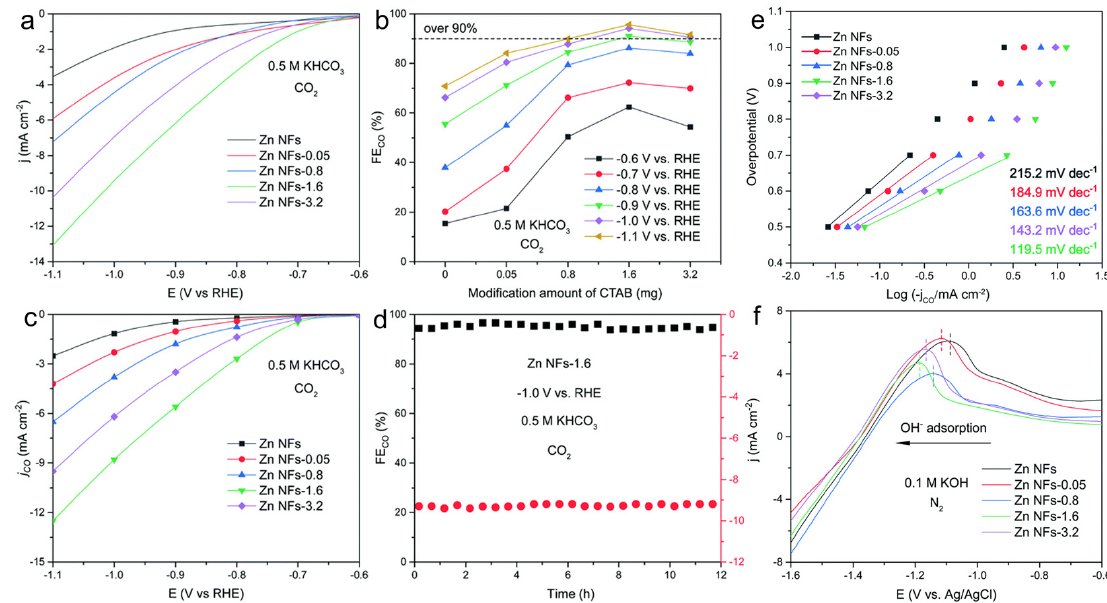
Figure 6. ( a ) LSV curves of Zn NSs modified with CTAB (0–3.2 mg). ( b ) FE CO of Zn modified with CTAB (0–3.2 mg). ( c ) j CO for Zn NSs and CTAB-modified Zn NSs. ( d ) Durability of Zn NSs-1.6 measured in potassium bicarbonate electrolyte (0.5 M). ( e ) Tafel slopes of Zn NSs modified with CTAB (0–3.2 mg). ( f ) Single oxidative LSV curves of samples measured in potassium hydroxide solution (0.1 M) [64]. Reproduced from Ref. [64] with permission from the Royal Society of Chemistry.